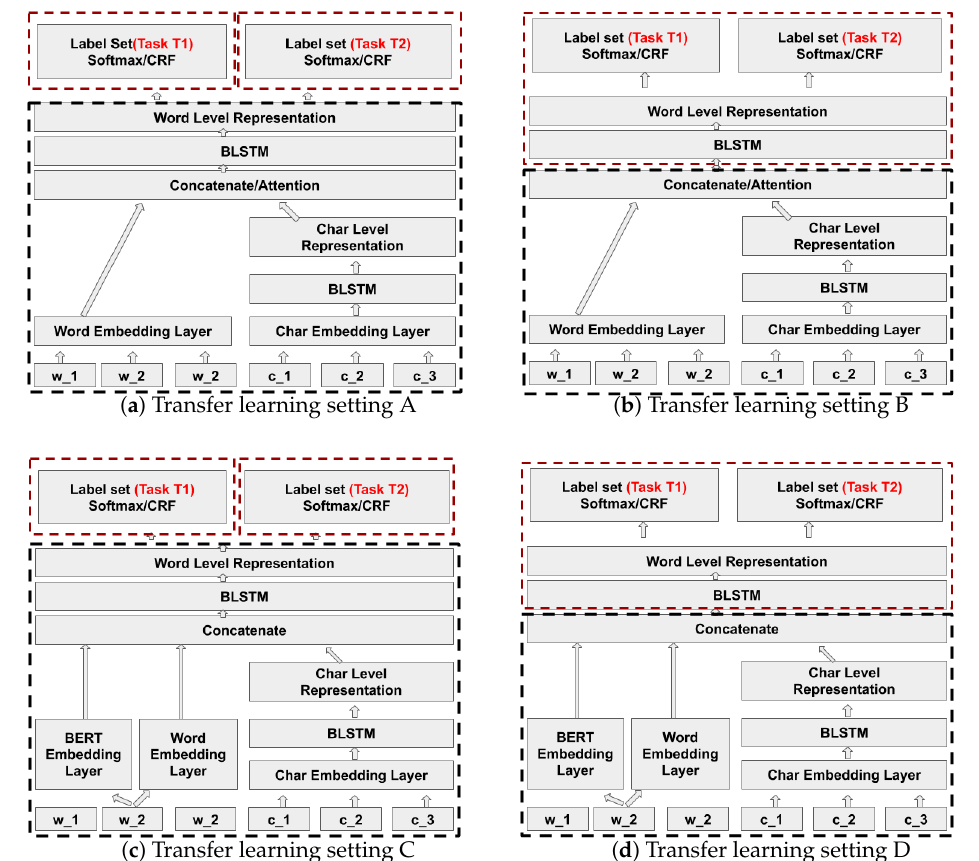
Figure 2. Transfer learning settings—The black stripped box indicates the shared parameters and the red stripped box indicates the fine-tuned parameters for a specific